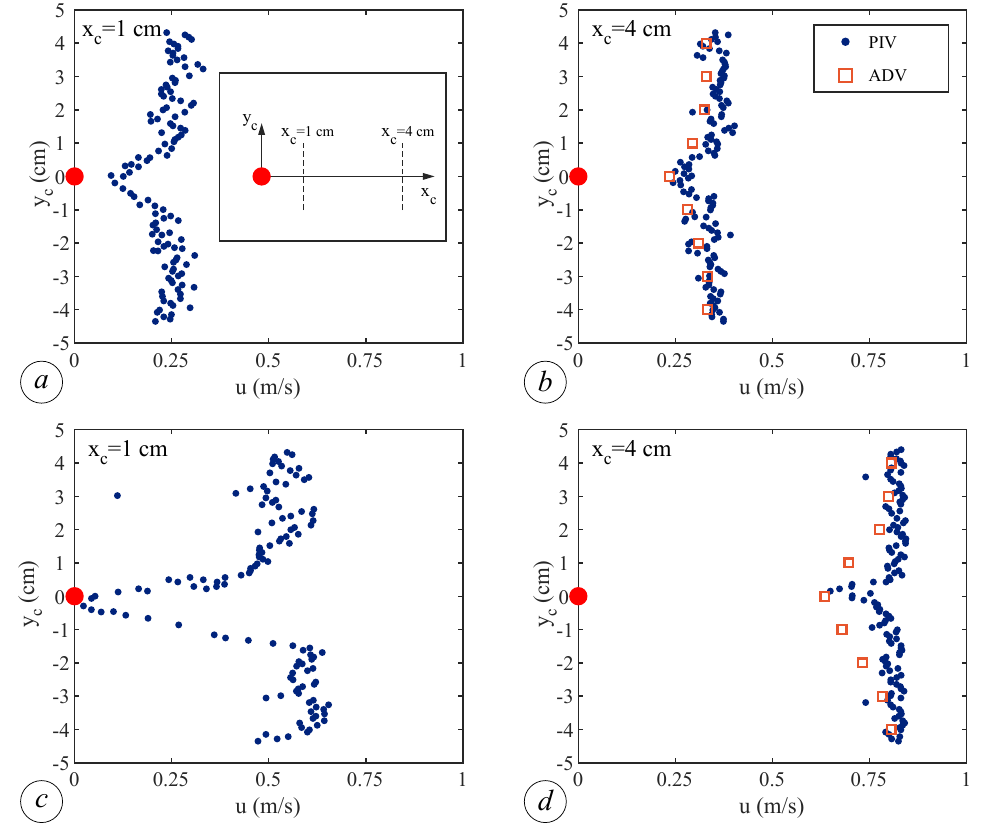
Figure 8. Transverse profiles of the longitudinal velocity component u , at x = 9.00 m and z = 2 cm, with vegetation density n = 156.25 cylinder/m 2 . Base flow conditions at x c = 1 cm ( a ) and at x c = 4 cm ( b ). Wave peak conditions at x c = 1 cm ( c ) and at x c = 4 cm ( d ). The origin of the local reference system ( x c , y c ) coincides with the center of the cylinder, represented by a red dot (inset of Panel ( a